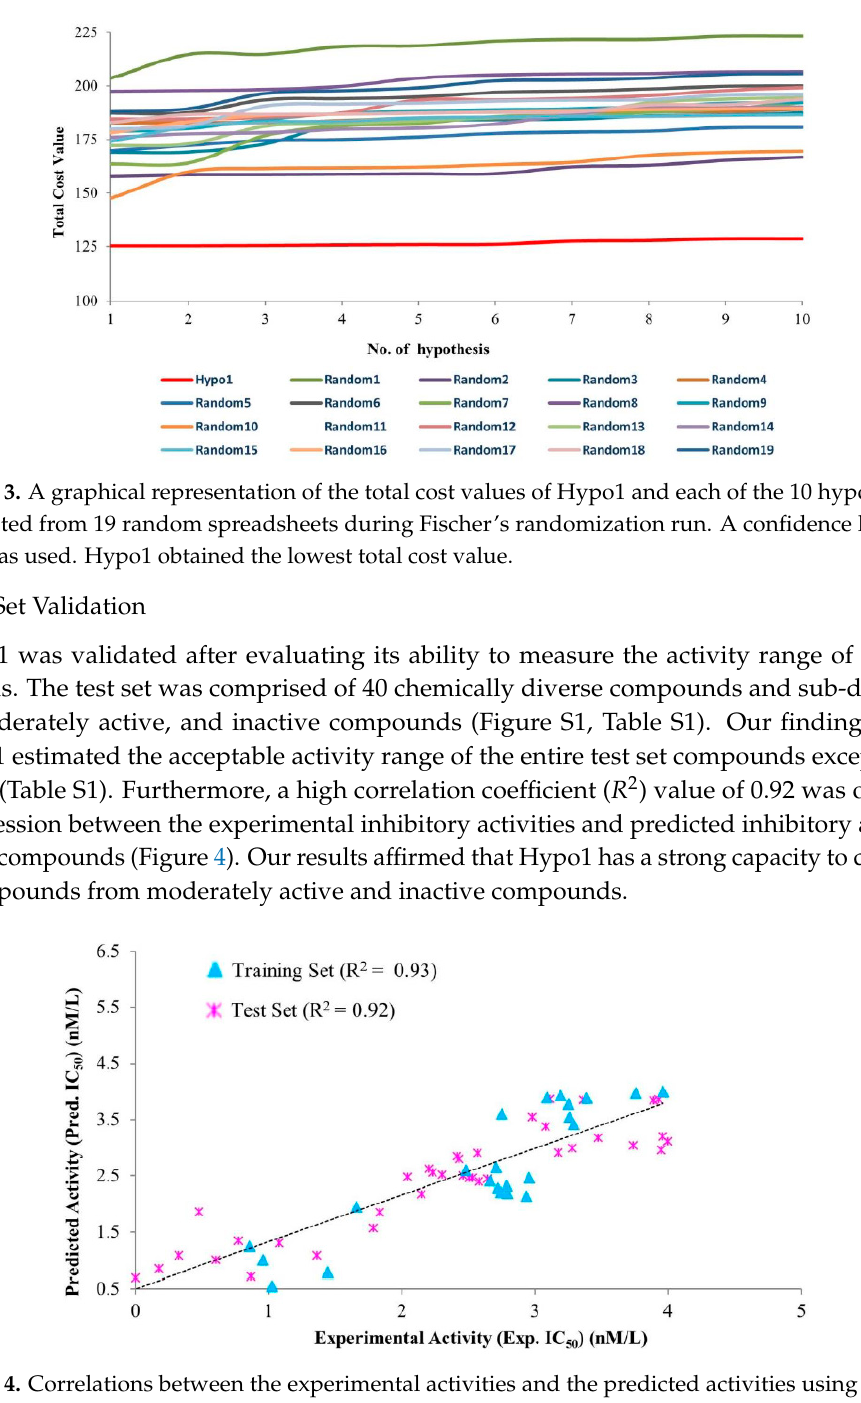
Table 3. Decoy set validation. The decoy set validation of Hypo1 obtained highest goodness of fit (GF) score (0.86) and suggested its suitability for virtual screening.